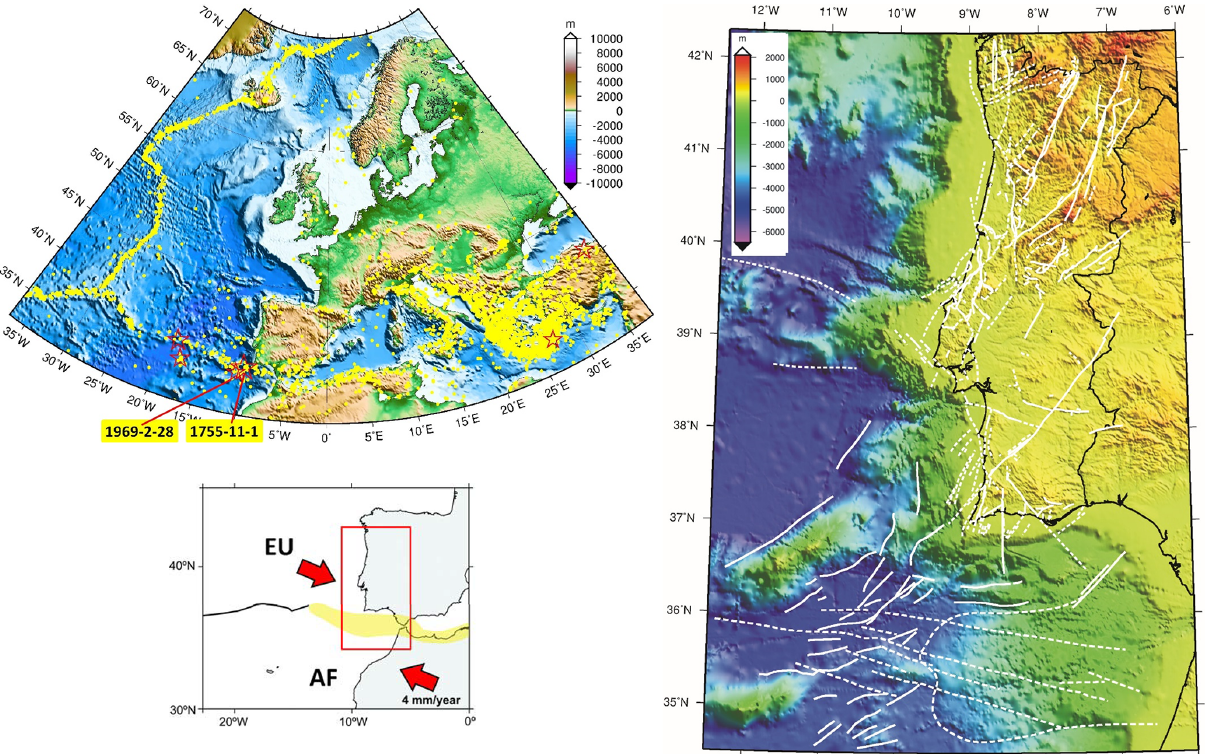
Figure 1. Geodynamic setting of the investigated area. (a) Seismicity in and around Europe. Yellow dots show earthquake epicentres with M ≥ 5.0 from ISC (2018) for the period 1900–2018. Red stars show epicentres of events with M ≥ 8.0 according to the European instrumental (Grünthal and Wahlström, 2012) and historical catalogues (Stucchi et al., 2013). (b) The plate boundary setting of the studied area. The light- yellow domain indicates a diffuse plate boundary. (c) Active and probable active faults identified in the western Iberian mainland and offshore areas (modified from Cabral, 2012 and Duarte et al.,